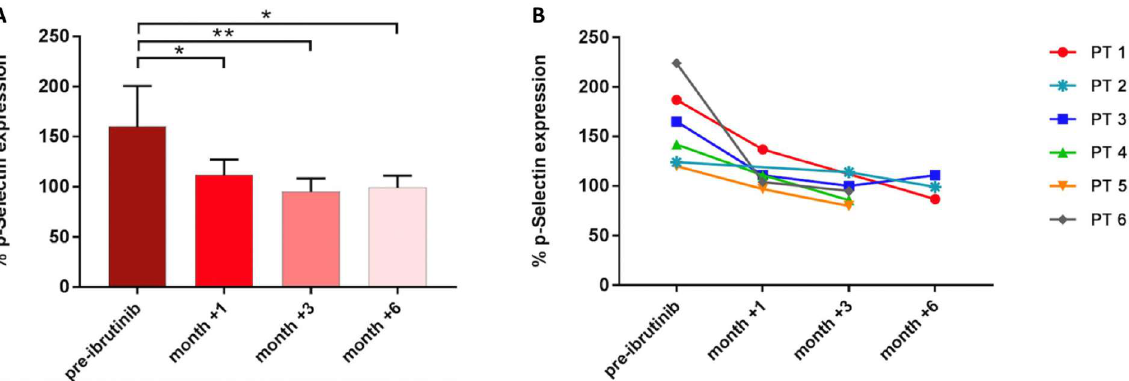
Figure 5. Platelet-mediated antifungal activity in CLL patients (PT) under ibrutinib. Bar ( A ) and line graph ( B ) showing P-selectin expression in samples collected before starting ibrutinib and during the course of treatment (* p < 0.05; ** p < 0.01).